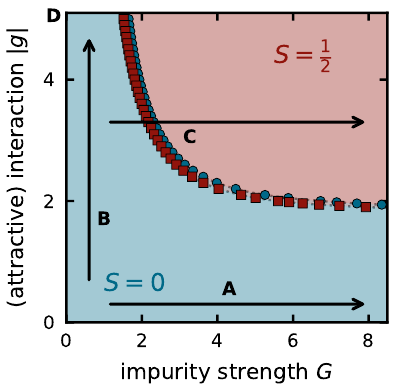
Figure 4: Few-body “phase diagram” with a magnetic impurity in the g − G plane . Different markers correspond to different fit functions as in Fig. 3 B. The three arrows schematically show the three cases discussed in panels A, B and C of Fig.